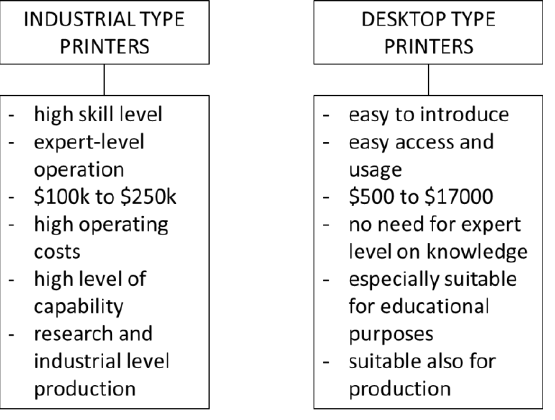
Fig. 1. AM printer type division